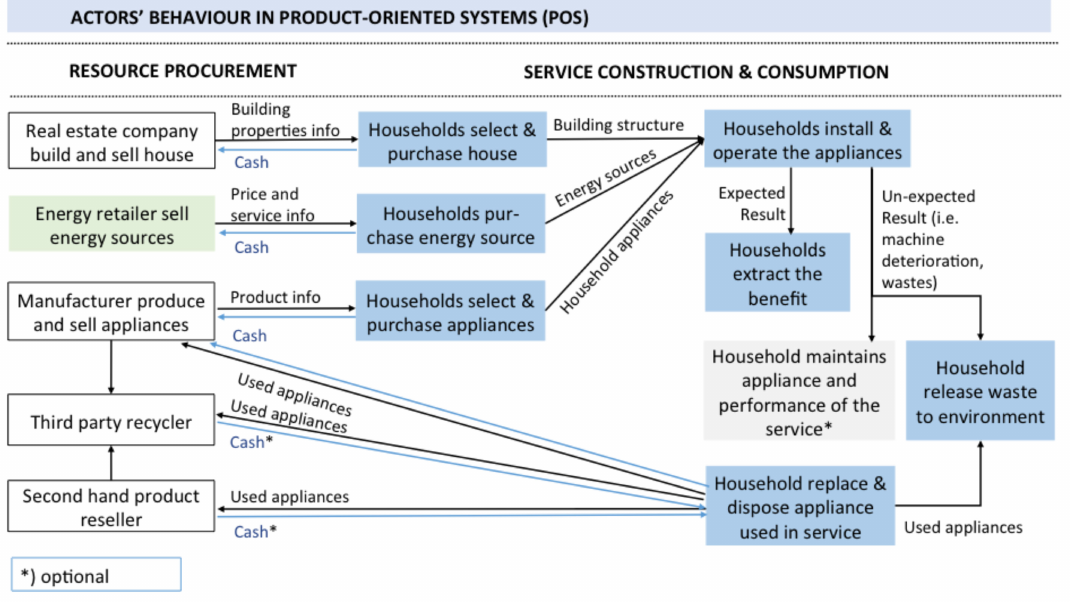
Figure 2. Actor’s behaviour in POS.